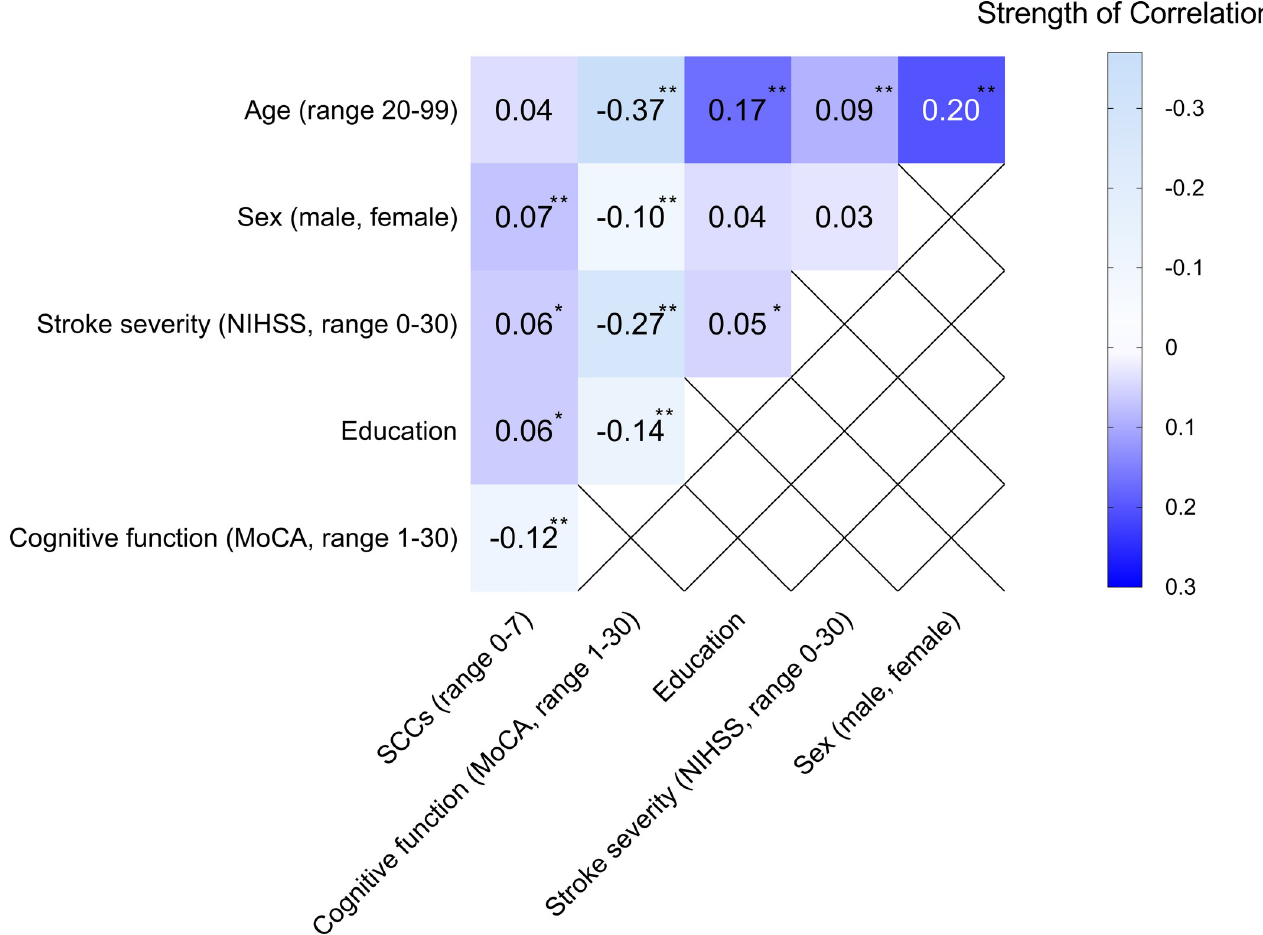
Fig 4. Correlational analysis between cognitive function screened at stroke units (Montreal Cognitive Assessment [MoCA]), age, sex, education, stroke severity at admission to the hospital (the National Institutes of Health Stroke Scale [NIHSS]), and subjective cognitive complaints (SCCs) three months after stroke. Statistics: Spearman’s rank-order correlation coefficient for continuous variables, Phi correlation coefficient for nominal variables. ** p < 0.01; * p < 0.05.